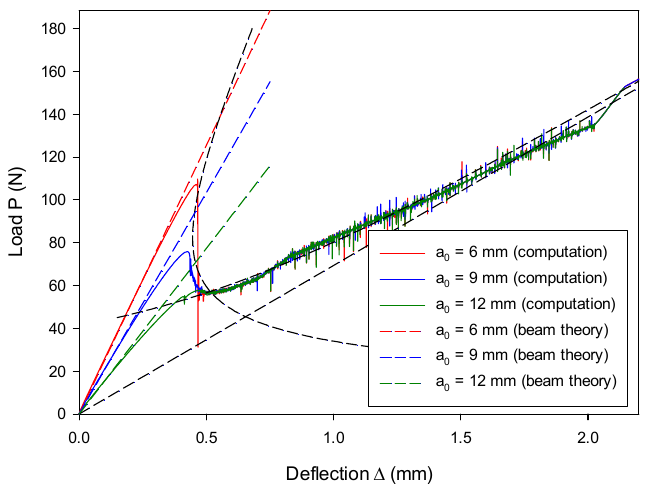
Figure 19. Load–deflection (P ∼ ∆ ) histories vary as a function of initial crack lengths a 0 .